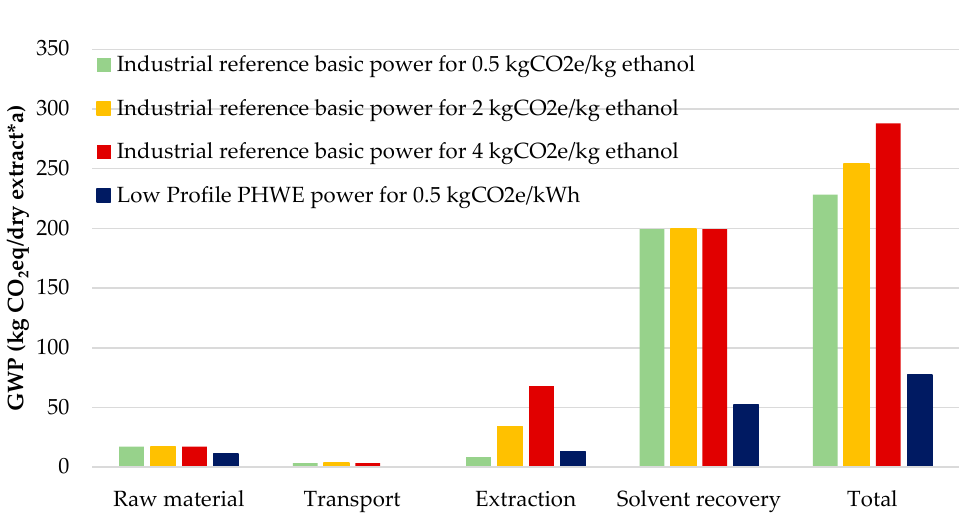
Figure 13. Dependence of extraction processes on indirect CO 2 emissions from power generation. Pressurized hot water extraction (PHWE).